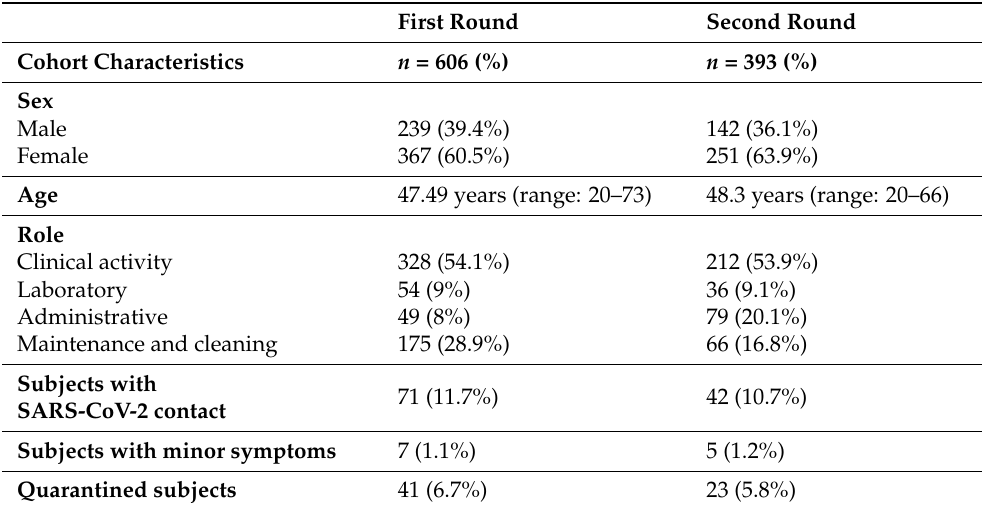
Table 1. Characteristics of the cohort of health-care workers screened for